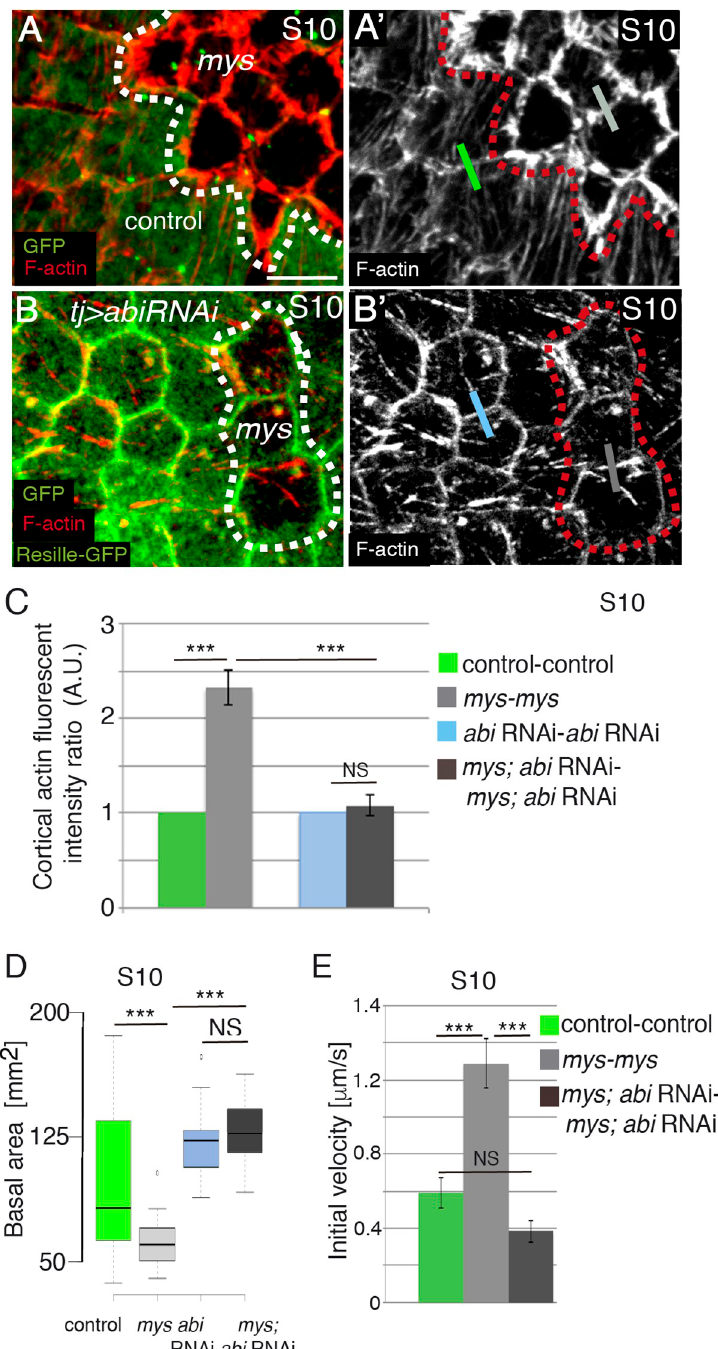
Fig 5. Integrins regulate basal surface area by controlling F-actin levels at cell edges. ( A, A’, B, B’ ) Basal surface view of S10 mosaic FE containing mys FC clones (GFP-negative) and ( B, B’ ) expressing an abi RNAi ( tj > abiRNAi ), stained for anti-GFP (green) and Rhodamine Phalloidin to detect F-actin (red). (C) Quantification of relative F-actin intensities along boundaries between cells of the indicated genotypes. (D) Quantification of the basal area of S10 FCs of the designated genotypes. (E) Quantification of initial velocity of vertex displacement of the indicated ablated cell bonds. The statistical significance of differences was assessed with a t-test, ��� P value < 0.0001. All error bars indicate s. e. Scale bars, 5 μ